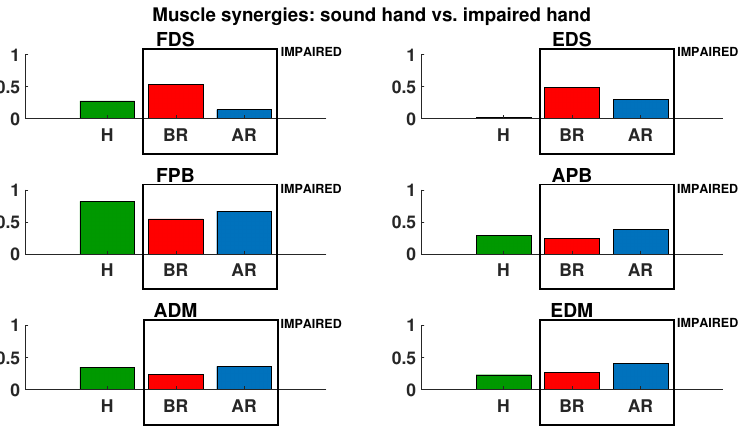
Figure 6. Comparison of the muscular synergies of the sound hand (in green) vs. the impaired hand (in the box) before (red) and after (blue) the rehabilitation treatment with the Gloreha robot for pencil-grasping.